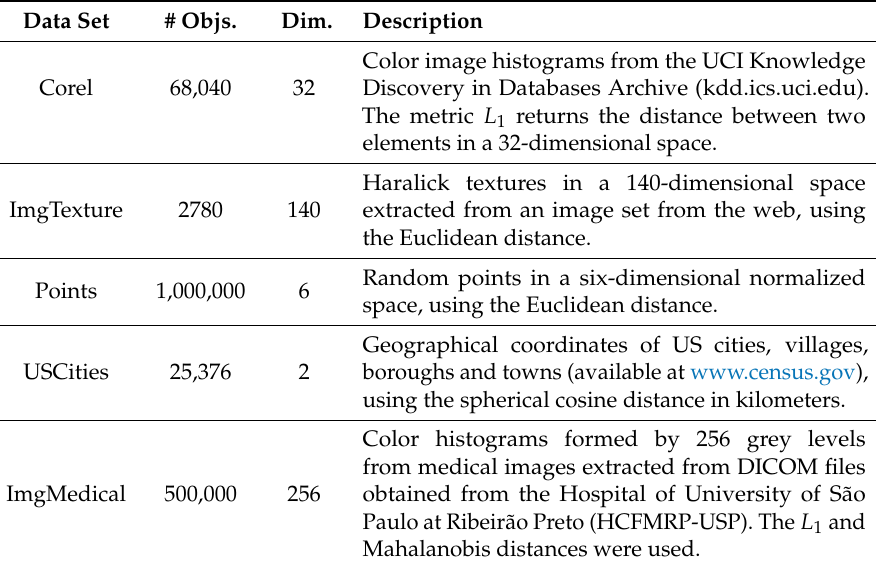
Table 2. Data sets description used in